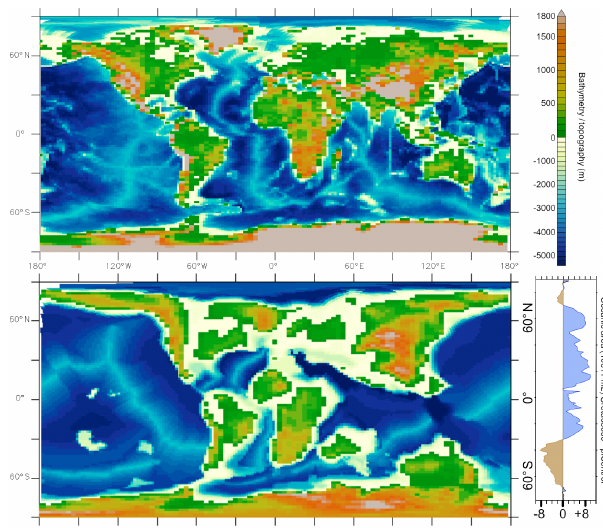
Figure 2. Modern and Cenomanian–Turonian geographic configu- rations used for the piControl and 4X-CRETACEOUS simulations respectively and meridional oceanic area anomaly between Creta- ceous palaeogeography and modern